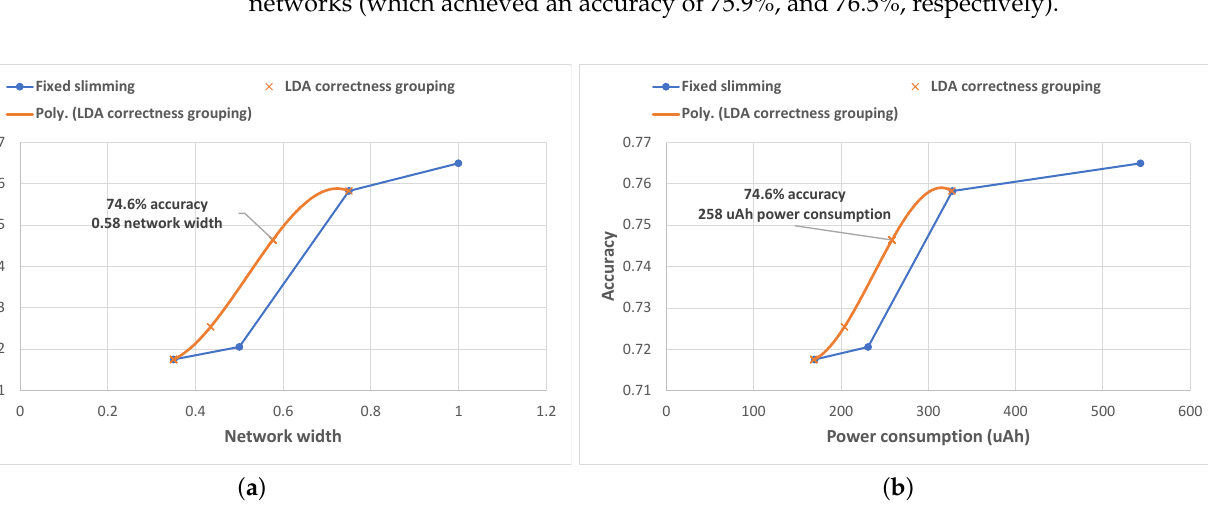
Figure 14. Experimental results obtained for the user study. ( a ) Accuracy vs. Network width. ( b ) Accuracy vs. Power